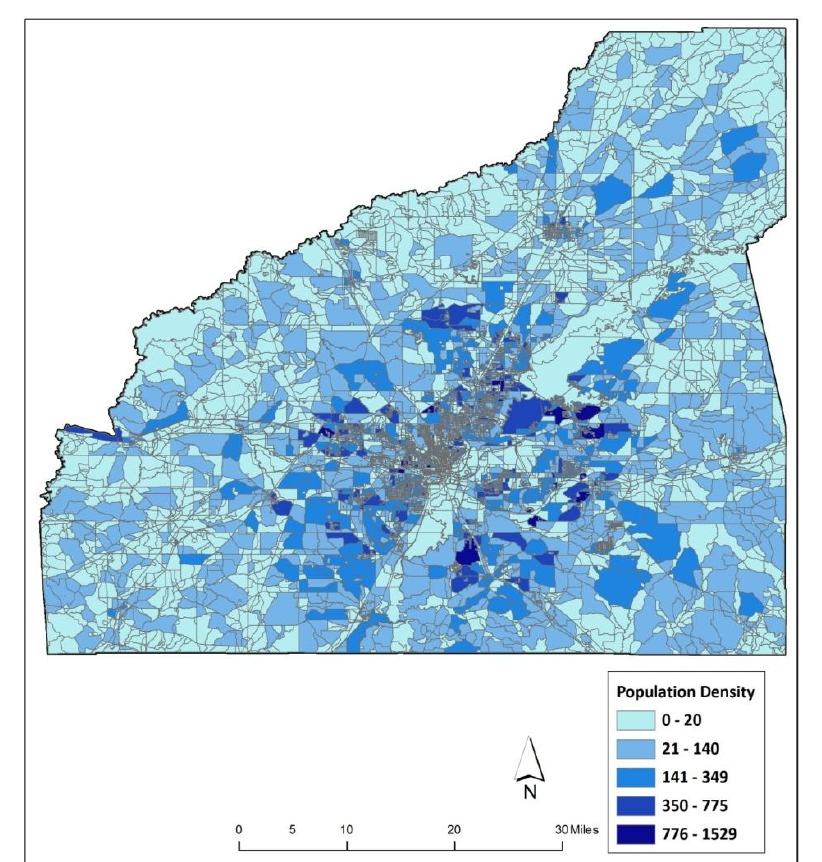
Figure 6. Population at block level in Hinds, Rankin and Madison County,